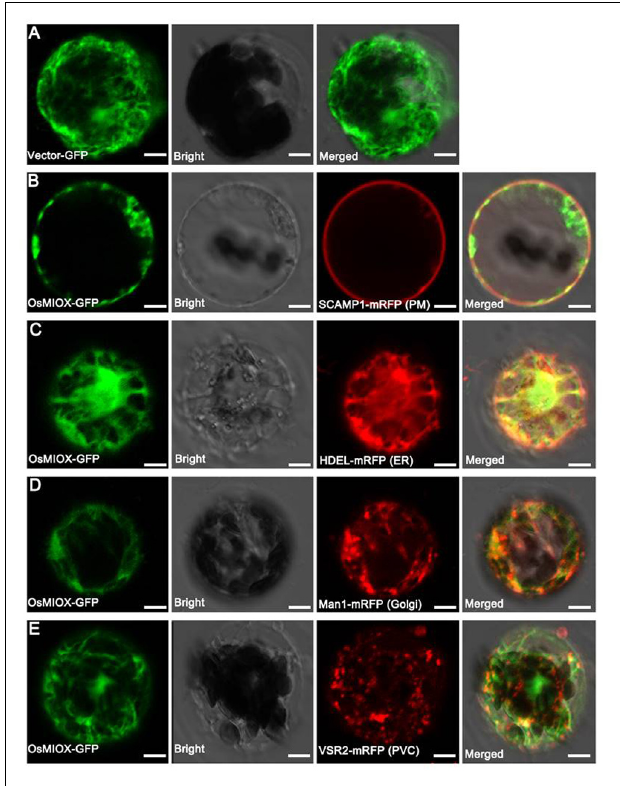
FIGURE 5 | Subcellular localization of OsMIOX in protoplasts of N. benthamiana leaves. (A) Fluorescence signal from the expression of the GFP tag. Fluorescence signal from the co-expression of the OsMIOX-GFP fusion protein and (B) SCAMP1-mRFP (PM marker), (C) HDEL-mRFP (ER marker), (D) Man1-mRFP (Golgi marker), (E) VSR2-mRFP (PVC marker). The scale bar corresponds to (A) 9 µ m, (B) 5 µ m, (C) 8 µ m, and (D,E) 10 µ